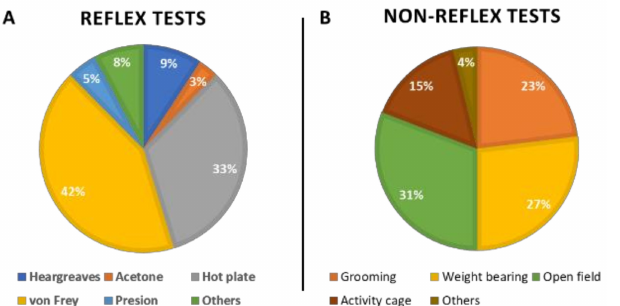
Figure 4. Behavioral tests used to assess endometriosis pain. Most frequent types of reflex ( A ) and non-reflex ( B ) tests used for evaluation of endometriosis-induced pain in rodent